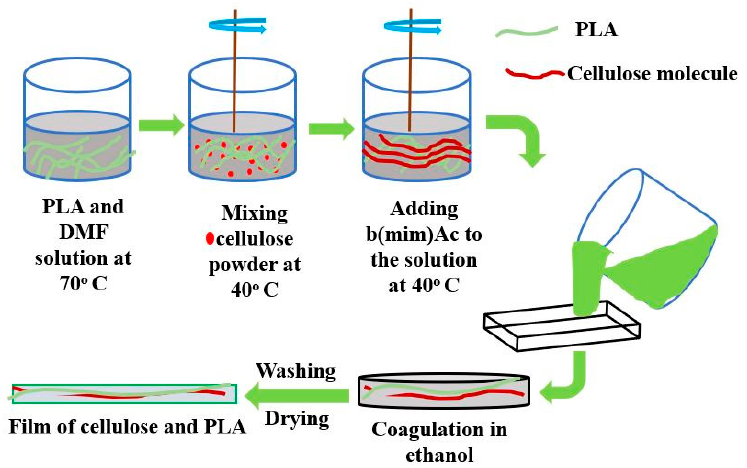
Figure 7. Preparation of cellulose–PLA film.